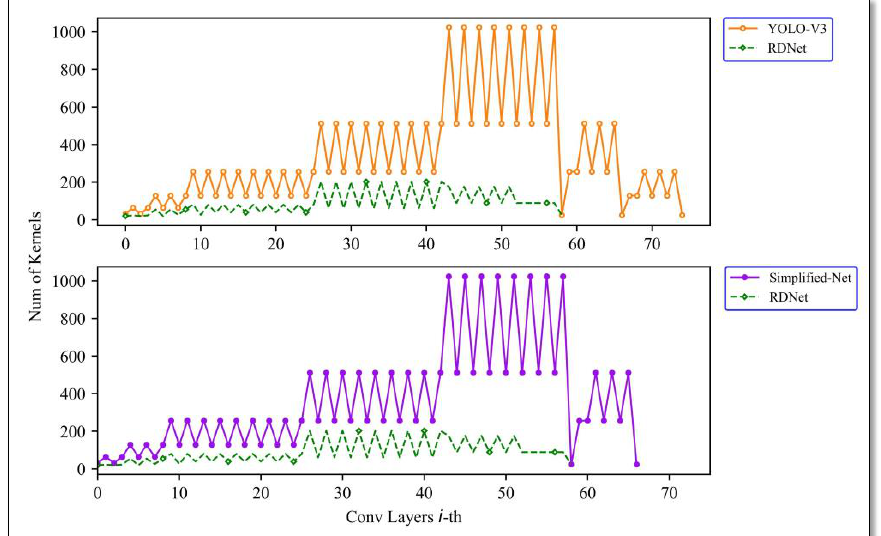
Figure 7. Comparison of convolutional kernels parameters of YOLO-V3, Simplified-Net and RDNet.